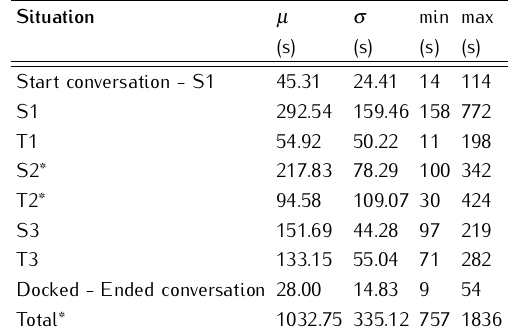
Table 2. A summary of the duration of each of the situations and transitions in the scripted scenario. The lines marked with a * exclude one partici-